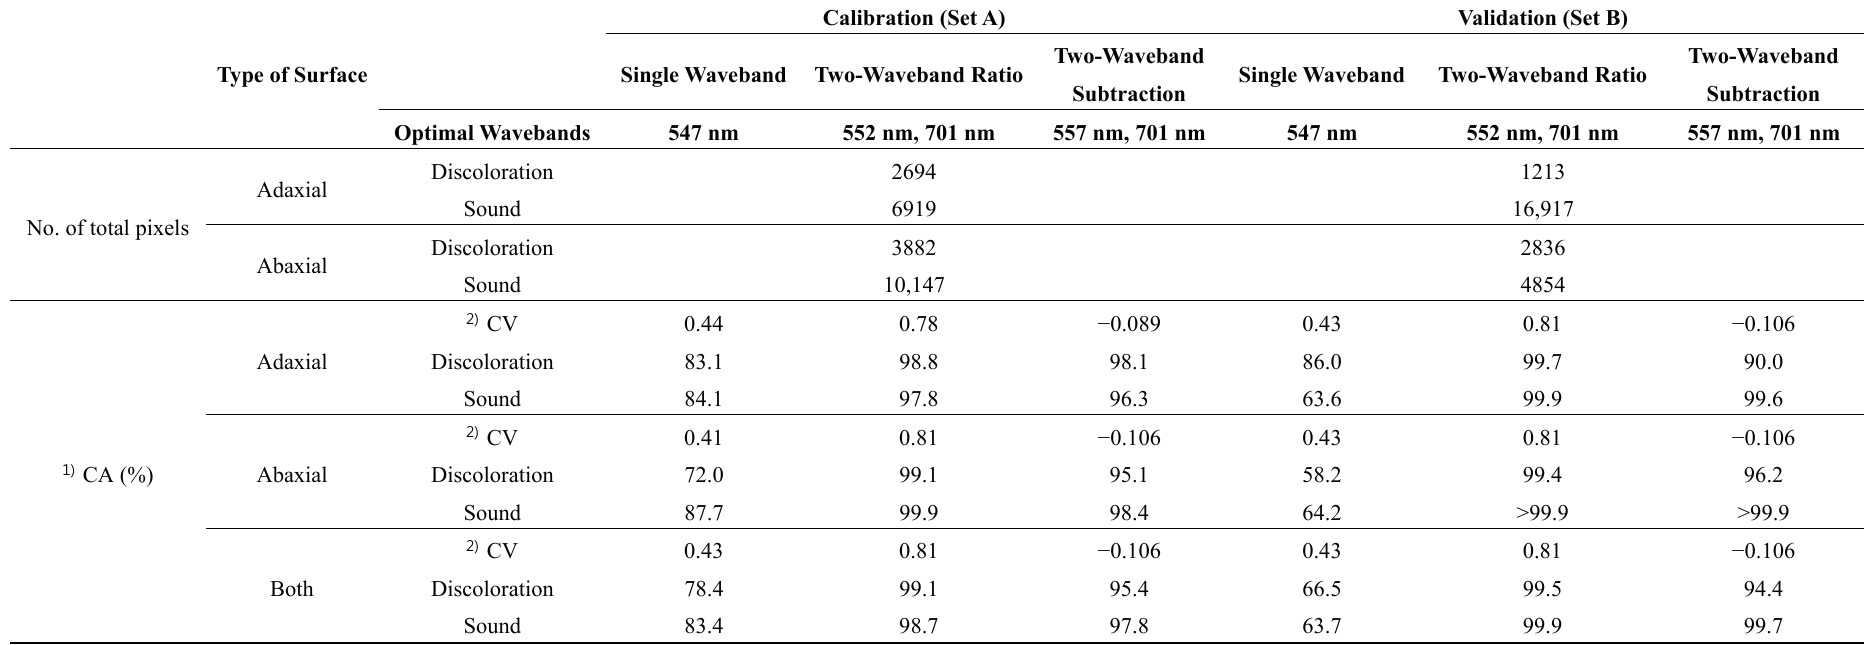
Table 2. Discoloration discrimination results using a single waveband algorithm and a combination of a two-waveband algorithm and pixel spectra.